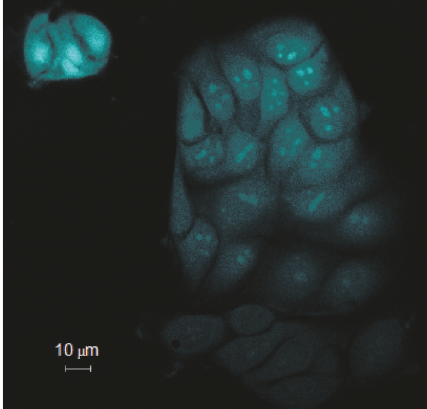
Figure 4: Microphotograph of MCF-7 cells incubated with 4b (28 𝜇 M, 20 min), 𝜆 em